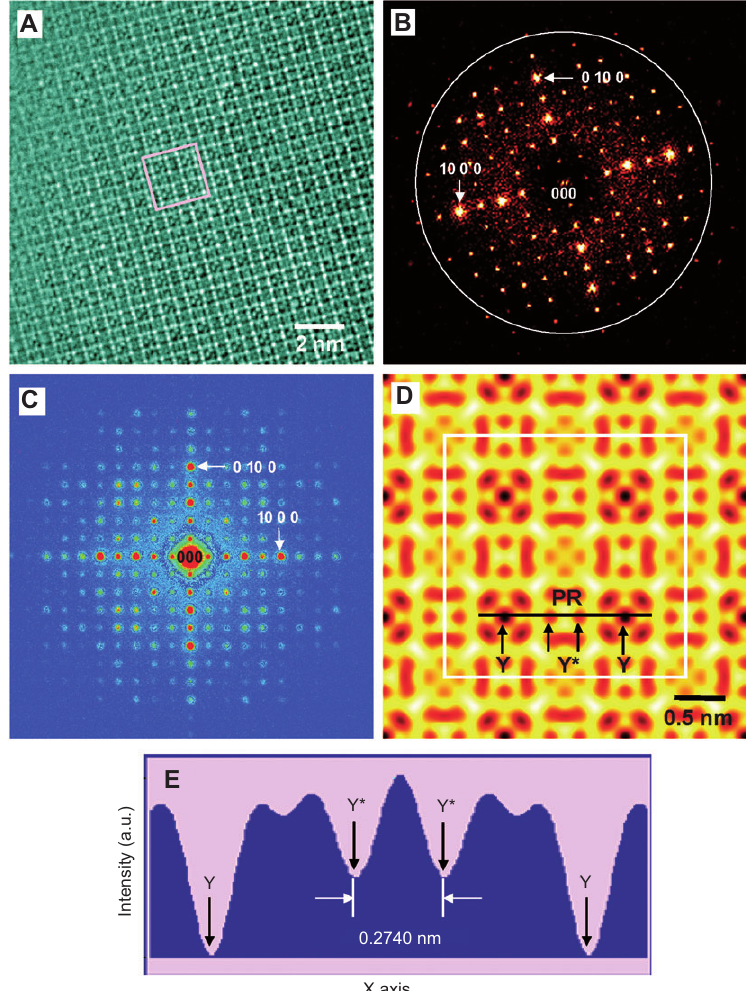
Figure 11 (A) HREM image of the thin part of the YB crystals taken along the [100] direction. (B) Fourier transform of (A). (C) Electron 56 diffraction pattern of YB observed along the [100] direction. (D) HREM image of YB reconstructed with amplitudes from electron diffrac- 56 56 tion patterns of (C). (E) Line profi le of image intensity of white line (PR) in